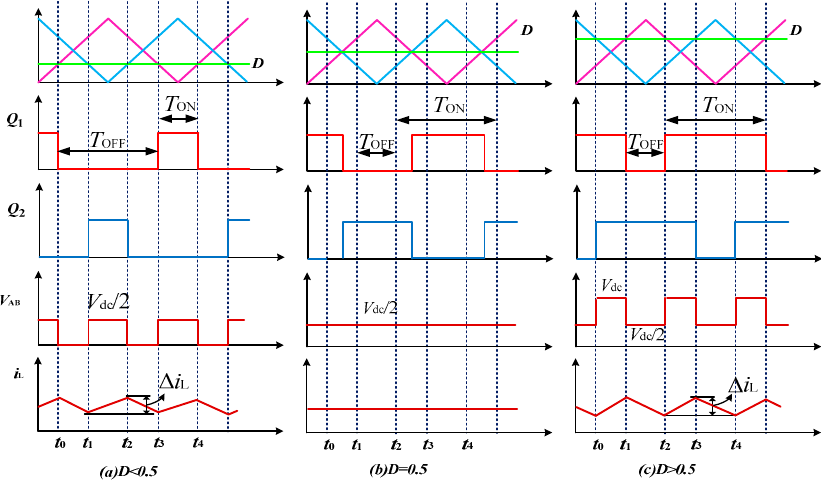
Figure 4. Main theoretical waveforms of the front-end three-level buck converter. ( a ) D < 0.5; ( b ) D = 0.5; ( c ) D > 0.5.